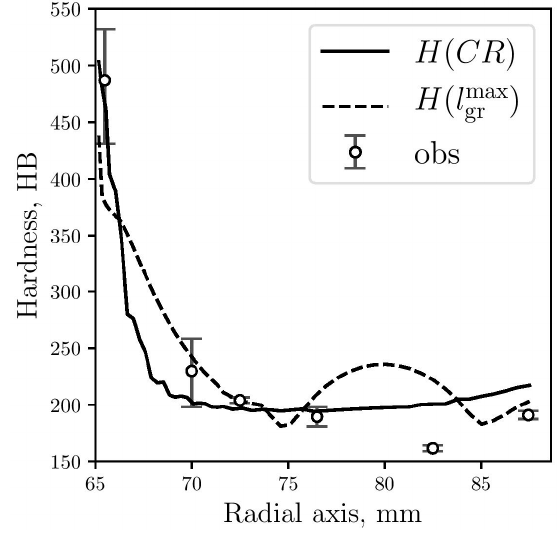
Figure 12. Hardness predicted by Equation (4) (continuous line) and Equation (7) (dashed line) compared with measured data (circles).